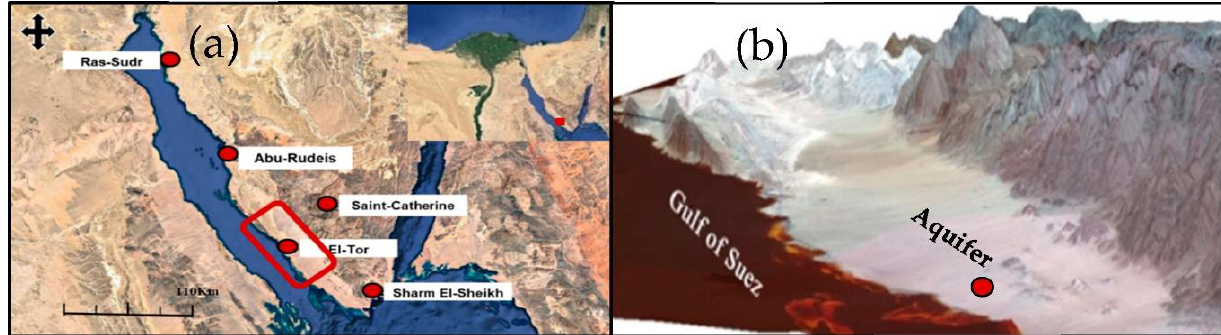
Figure 1. ( a ) Satellite map showing the research area. El-Tor city is delineated in red, and the five surrounding cities are depicted as red-filled circles that are identified (source: Google Earth, 2017) (Modified after [4]). ( b ) 3D view of the test site shows the location of the aquifer and El-Tor city (Modified after [18]).